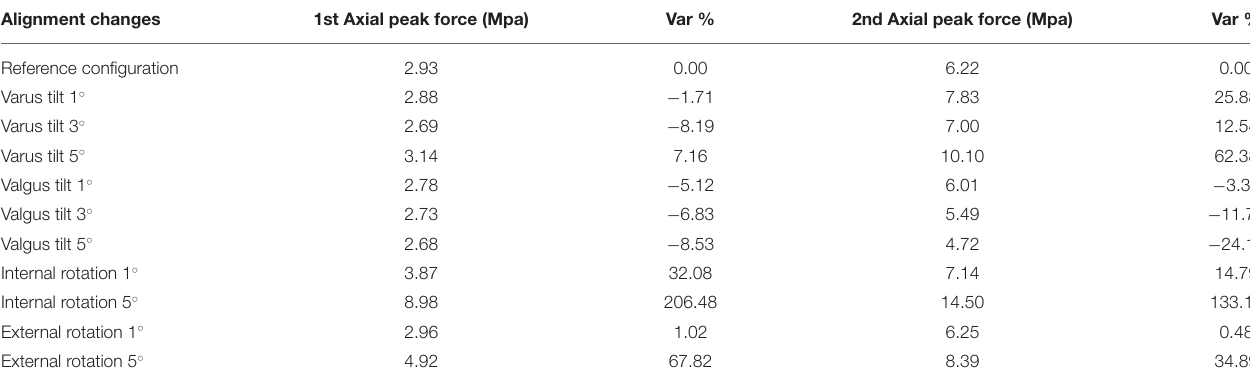
TABLE 3 | Maximum contact pressures at different femoral component misalignment conditions. Alignment